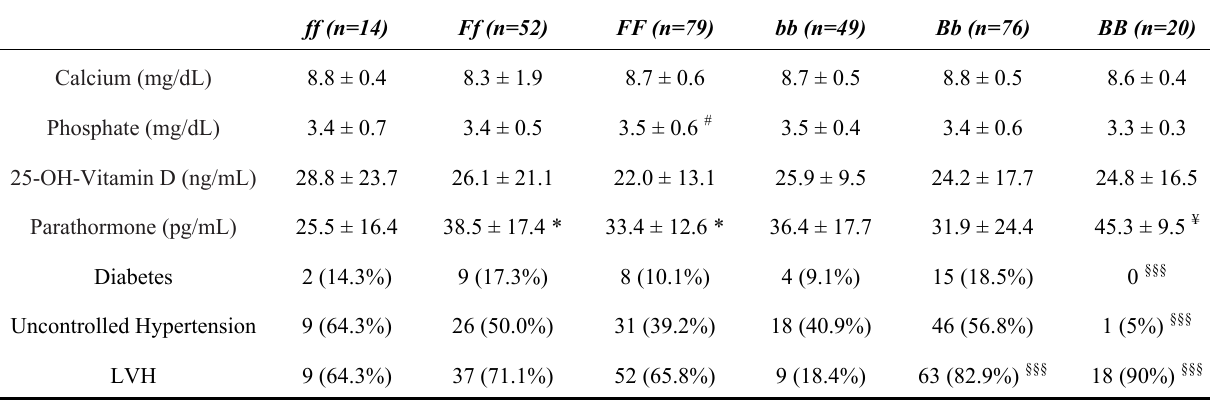
Table 3. Variability of biochemical markers and distribution of co-morbid conditions in relationship to FokI and BsmI VDR genotypes in CKD 3b patients.